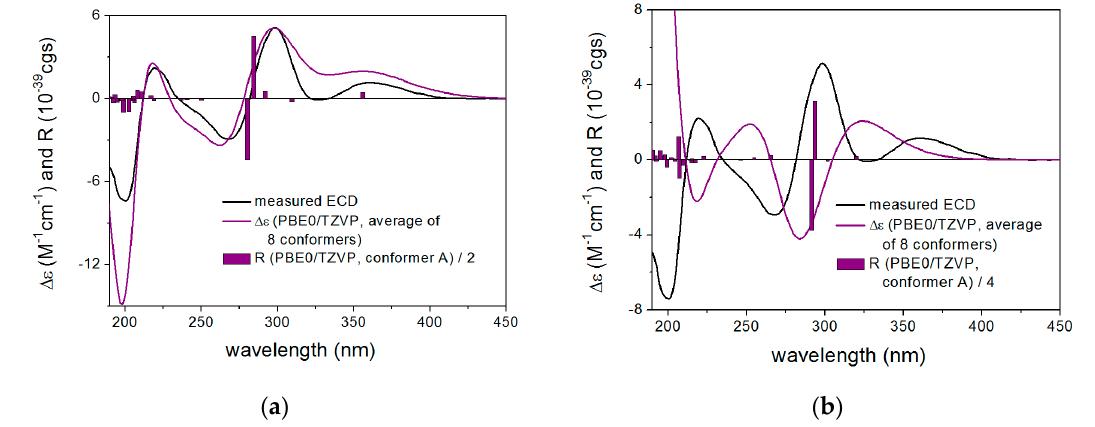
Figure 1. Experimental ECD spectrum of 15 in MeCN compared with the Boltzmann-weighted PBE0/TZVP PCM/MeCN ECD spectra of ( a ) (1’ R )- 15 and ( b ) (1’ S )- 15 both computed for the ω B97XD/TZVP PCM/MeCN conformers. The bars represent the rotational strength values of the lowest-energy conformers.